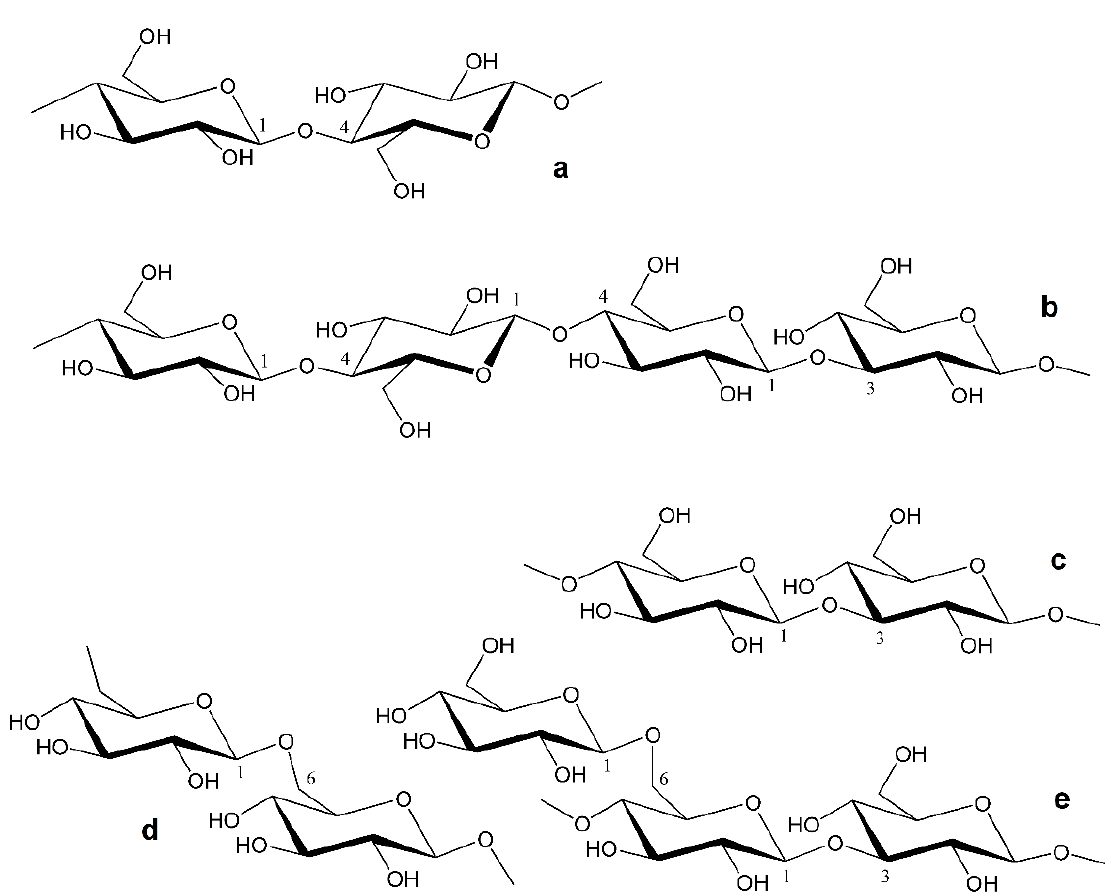
Figure 1. Structure of common β - D -glucans: ( a ) cellulose, ( b ) cereal mixed-linkage (1 → 3) (1 → 4)- β - D -glucan, ( c ) microbial (1 → 3)- β - D -glucan, ( d ) (1 → 3)- β - D -glucan from lichens, ( e ) branched fungal or seaweed (1 → 3) (1 → 6)- β - D -glucan.